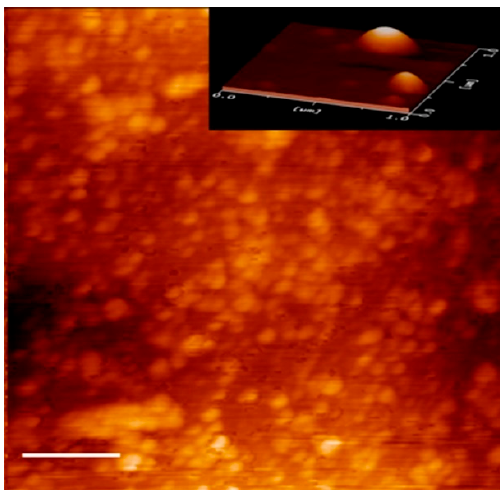
Figure 1. Atomic force microscopy (AFM) topography images of the CNp. The size bar is 1 μ m.